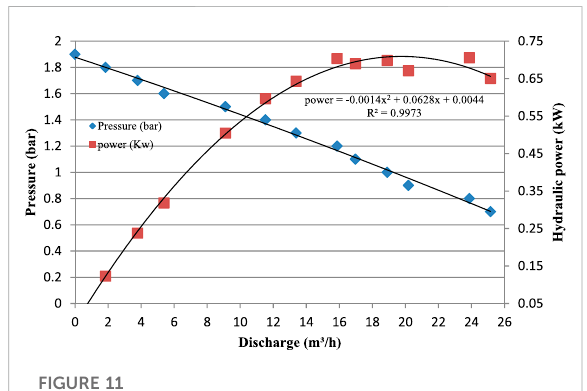
FIGURE 10 The relationship between discharge, pressure, and hydraulic power of a pump operating with the T45 mixer at an engine speed of 3,500 rpm.